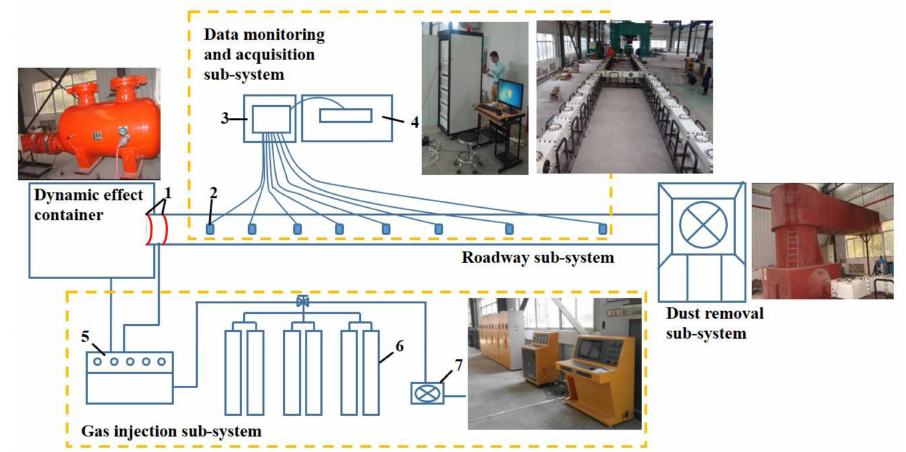
Figure 2. The simulation test device for dynamic effect of coal and gas outburst: 1—Rupture disk; 2—Pressuretemperatureconcentration sensor; 3—Multi-function data acquisition controller; 4—Display and operating platform; 5—Controller; 6—Gas cylinder; 7—Vacuum